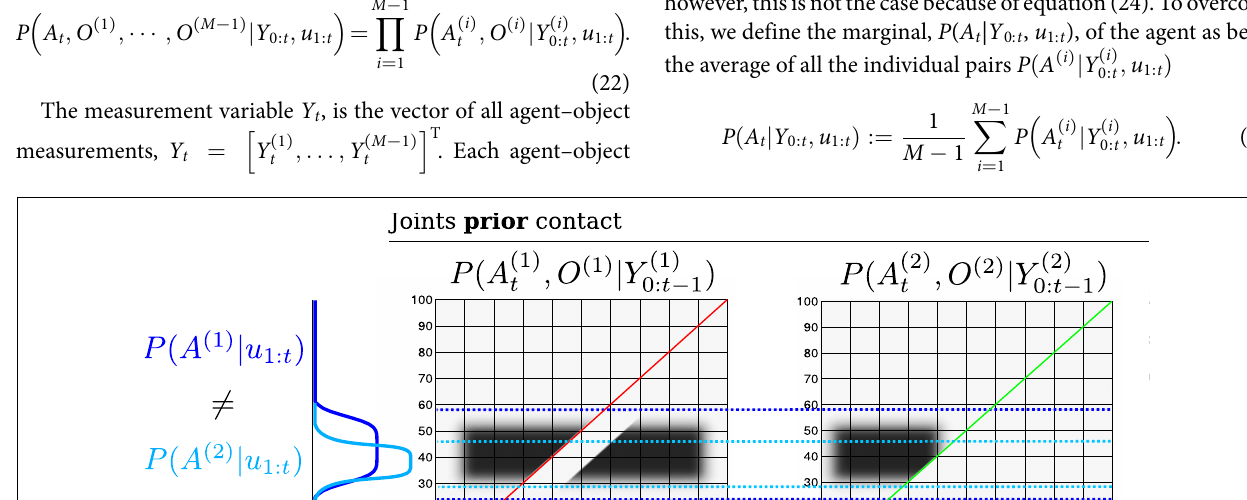
Frontiers in Robotics and AI |